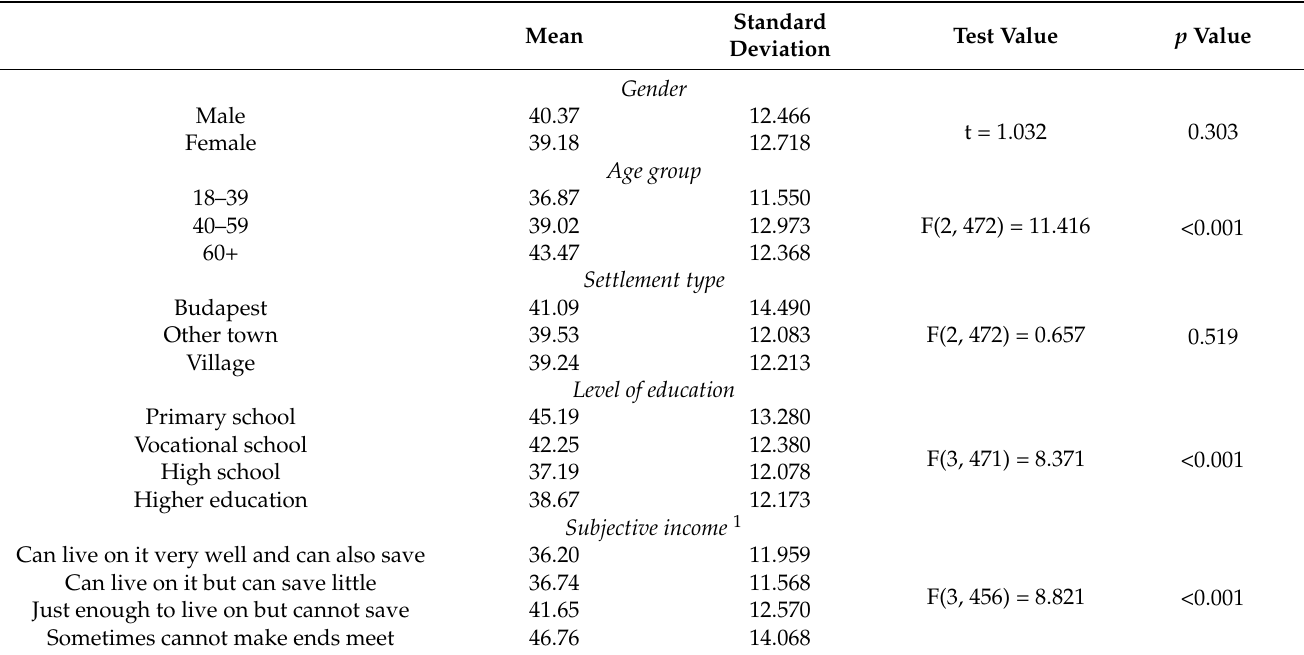
Table 3. Mean values of the FNS according to demographic variables.